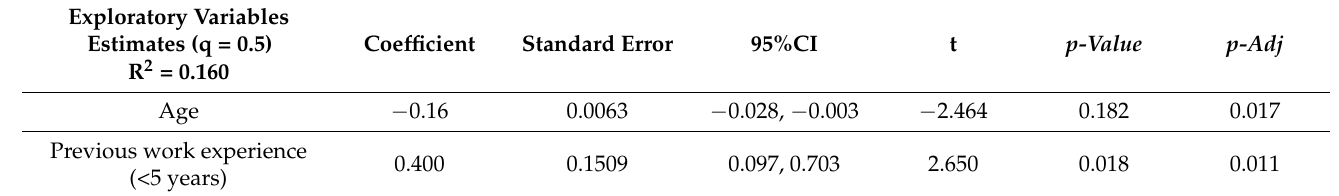
Table 3. Results of multivariate quantile regression analysis of factors predicting probable mental health disorder (N = 56) (Dependent variable HSCL-10 ≥